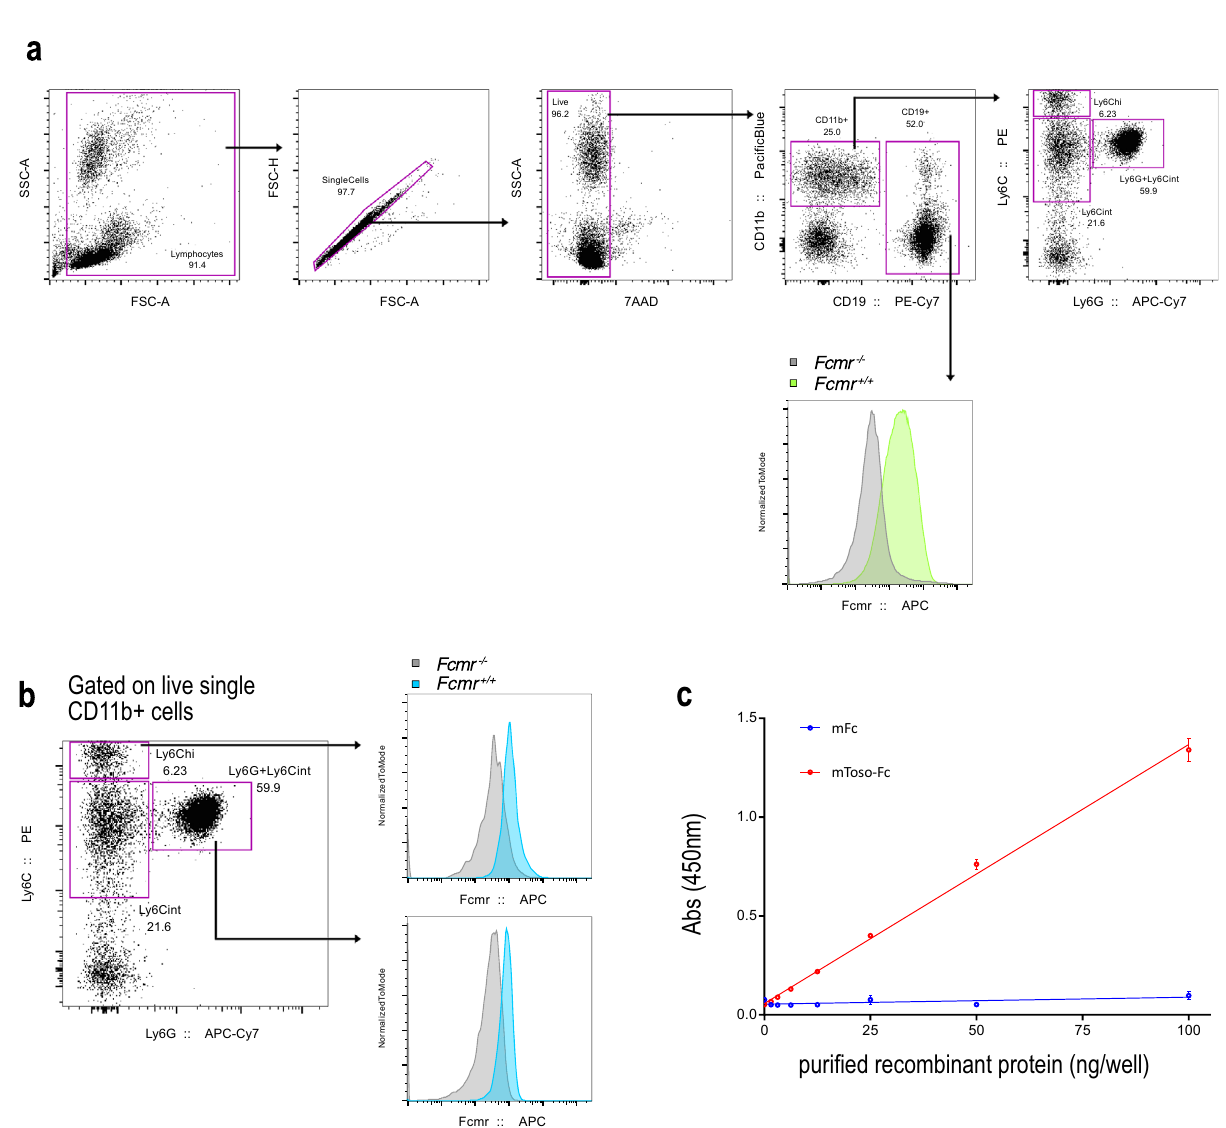
Fig. 2 Fcmr is expressed in classical monocyte and neutrophil innate-immune cells. a (Top) Gating schematic for peripheral blood staining implementing an in-house anti-mouse-Fcmr antibody. (Bottom right) Histogram overlay of Fcmr staining of peripheral blood B cells in Fcmr + / + (green) mice where Fcmr − / − (gray) serve as a negative control. b (Left) Dot plot illustrating peripheral blood CD11b + monocyte and neutrophil populations. (Right) Histogram overlay of Fcmr staining of peripheral blood innate immune cells in Fcmr + / + (blue) mice where Fcmr − / − (gray) serve as a negative control. c Direct ELISA illustrating speci fi c recognition of the extra-cellular domain of mouse Fcmr with in-house α -mouse-Fcmr antibody. Technical triplicates are represented with